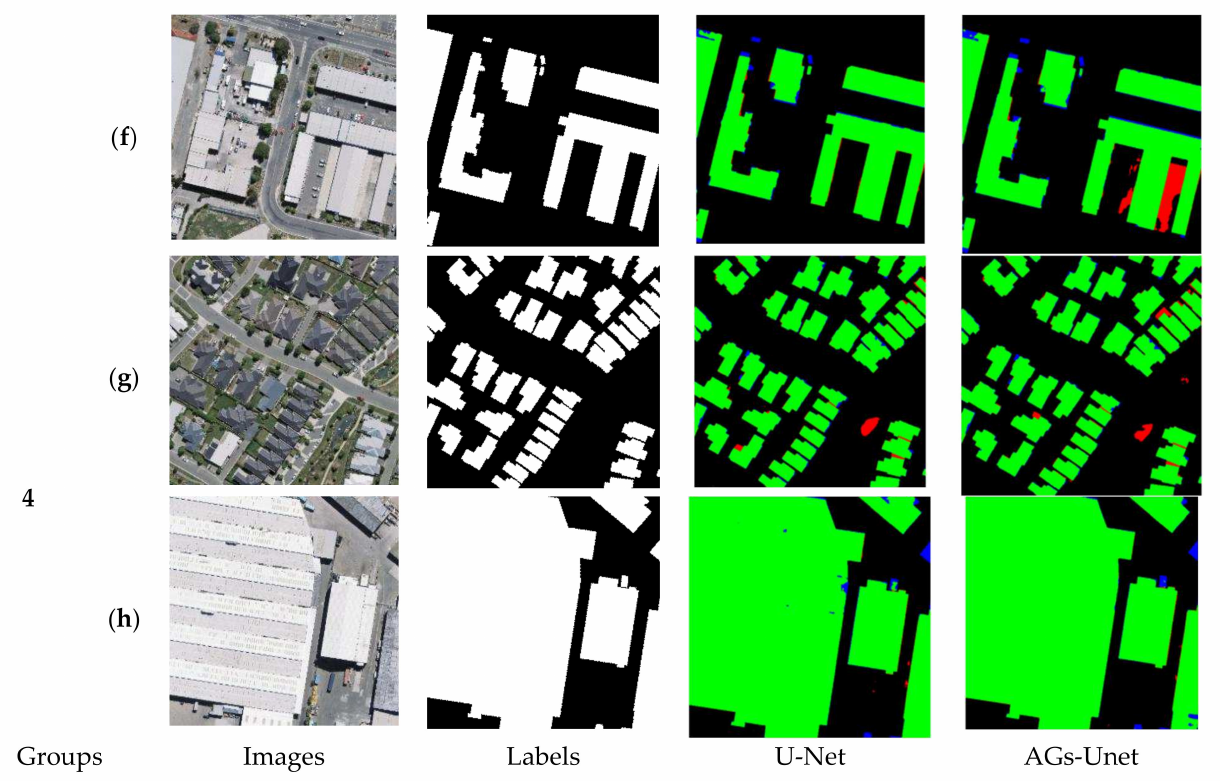
Figure 6. Experimental visualization results of each group. Each team selected two representative images to test the model trained by U-Net and AGs-Unet, where green represented buildings correctly extracted, blue represented buildings missing, red represented buildings incorrectly extracted, and black represented